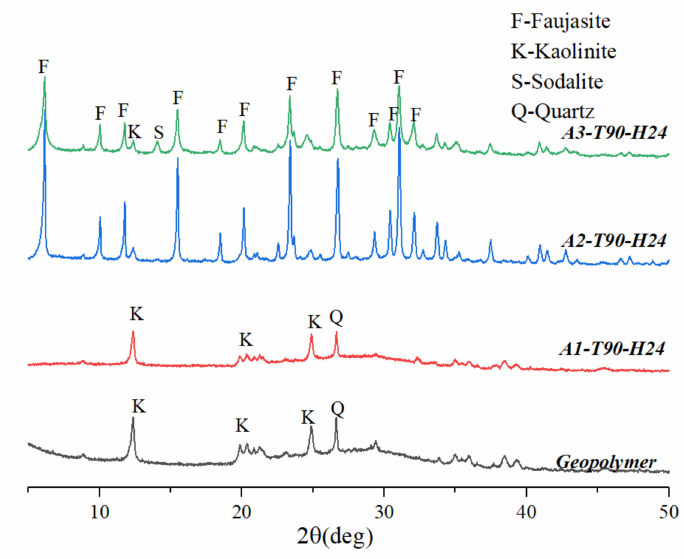
Figure 1. XRD patterns of samples synthesized at di ff erent hydrothermal alkalinity.